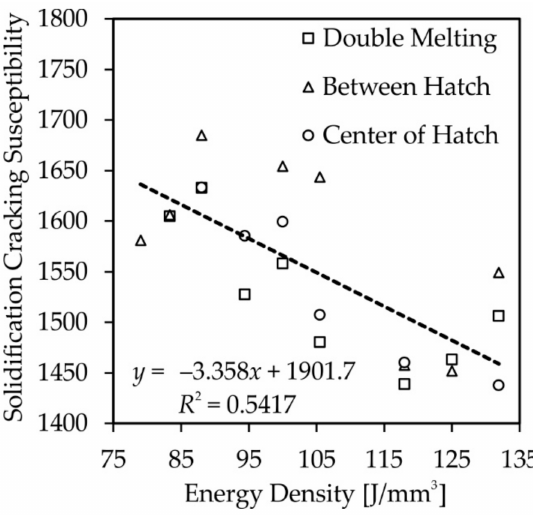
Figure 6. Solidification cracking susceptibility in stainless steel 316L as a function of energy density calculated by the diffusion-controlled transformations (DICTRA) model using the solidification cracking susceptibility model proposed by Kou. The trend line considers data from all three locations shown in Figure